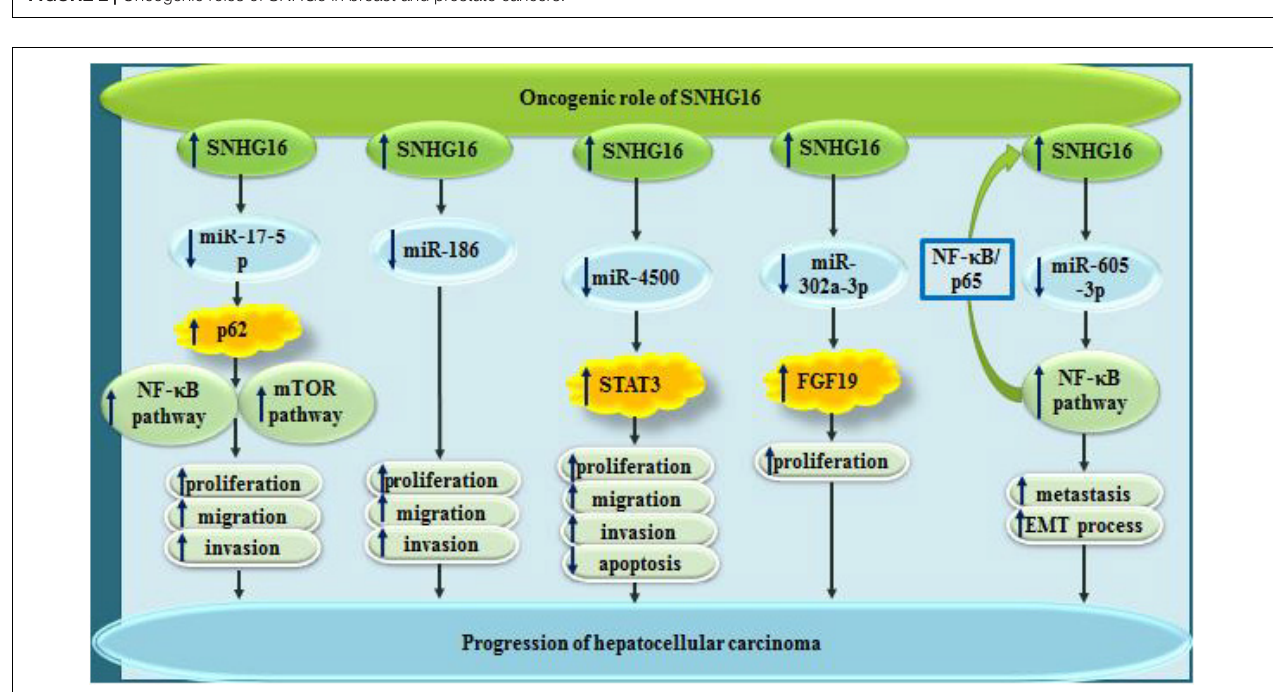
FIGURE 2 | Oncogenic roles of SNHG6 in breast and prostate cancers.